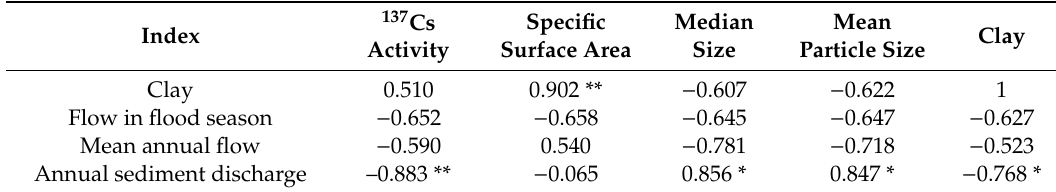
Table 2. Correlation analysis between hydrological indicators of Liaohe River and sediment particle size